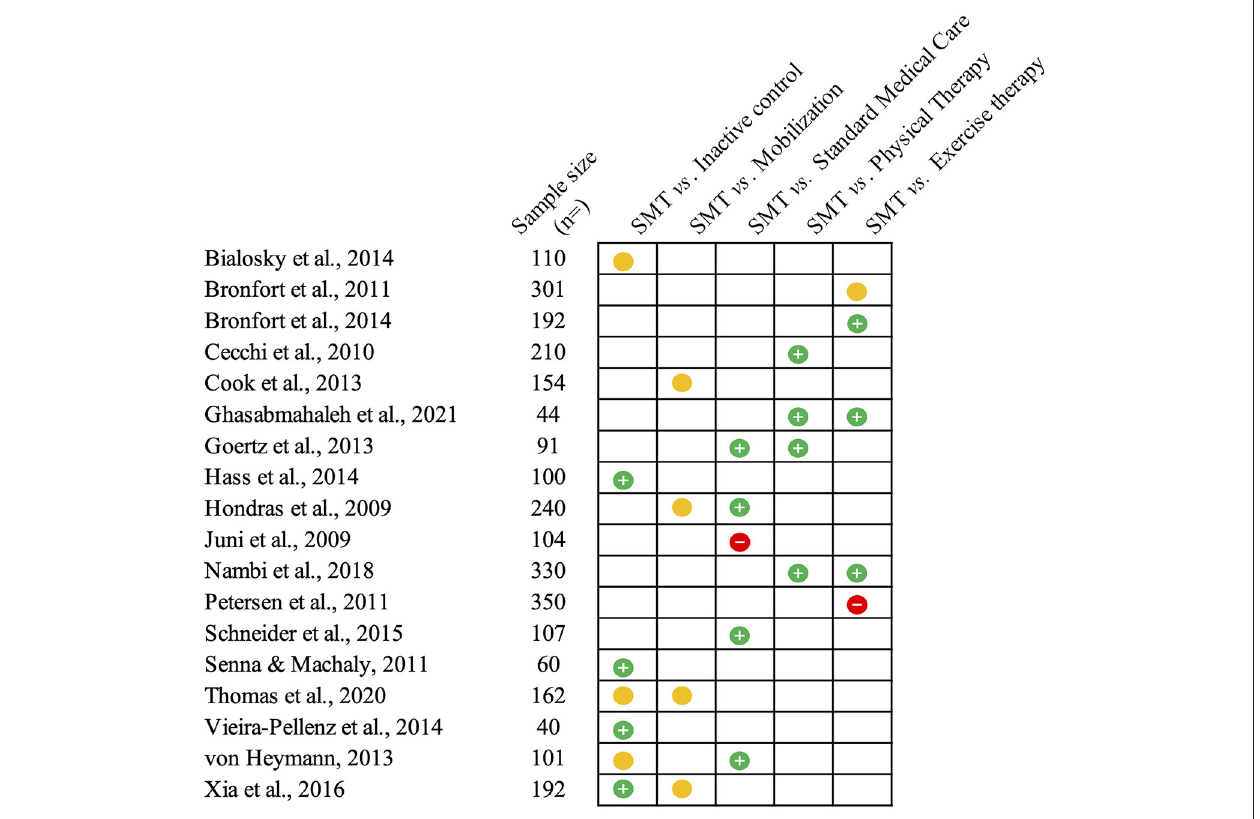
FIGURE 2 | Summary of the studies reviewed on low back pain. This figure summarizes the main findings from the studies presented on the efficacy (compared to inactive controls) and effectiveness of spinal manipulative therapy (SMT) against different comparators for acute and chronic low back pain. The green circles with the positive sign indicate studies reporting pain-related outcomes in favor of SMT against or when added to the comparator. Yellow circles indicate similar effectiveness. Red circles with a negative sign indicate that SMT is inferior or does not add any value to the